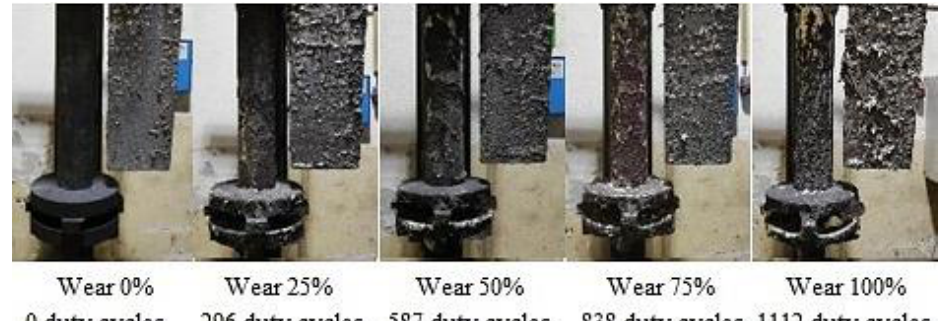
Figure 3. Type A rotor wear.